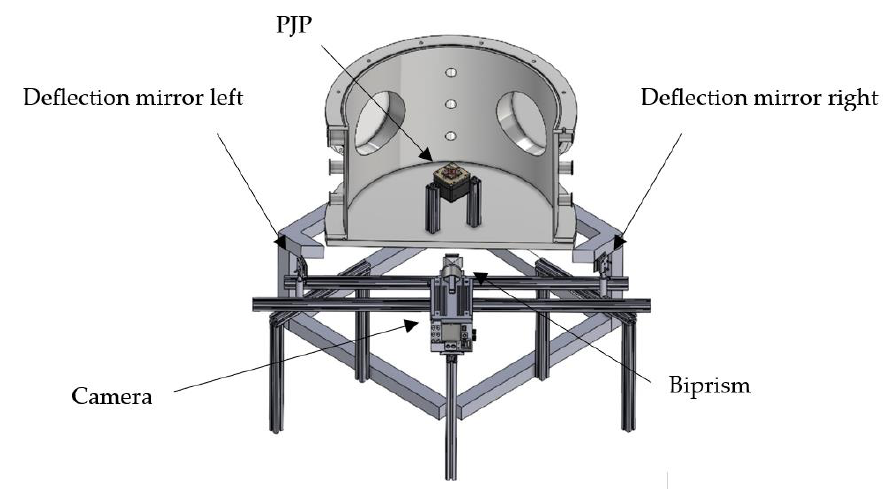
Figure 4. Vacuum chamber with PJP and arrangement of the used optical measurement system.